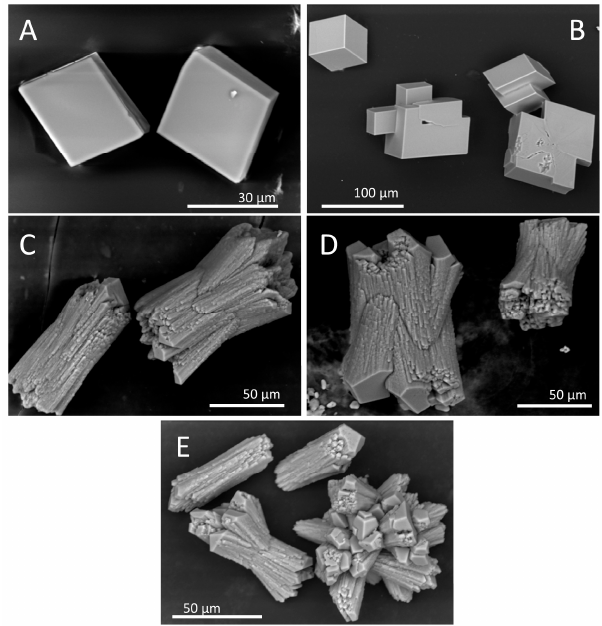
Figure 6. Scanning electron microscopy (SEM ) images of the calcium carbonate precipitates obtained in vitro. Precipitates were obtained in the ( A ) absence and presence of Gad m 1 ( B ) wt monomer, ( C ) wt amyloids, ( D ) I12C amyloids and ( E ) C19S amyloids. The protein concentration was 0.2 mg/mL.